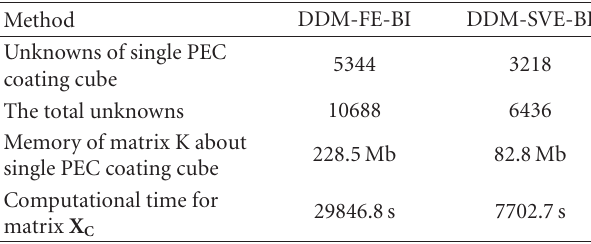
Table 2: The comparison of the DDM-FEM-BI and